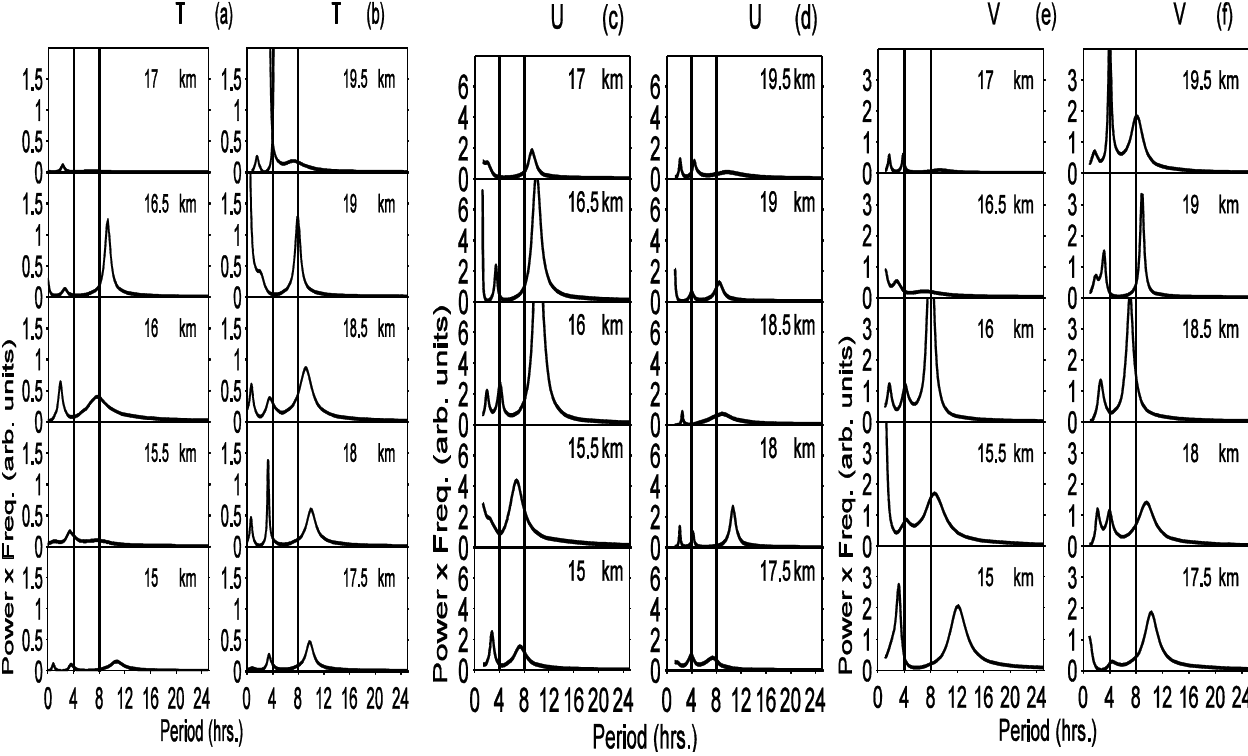
Fig. 8. From the spectrum of U , V , and T , we can infer dominant wave periods on 30 November 2005 at different height regions (from 15 Figure 8. From the spectrum of U, V, and T, we can infer dominant wave periods on 30 November 05 at to 19.5km, at an interval of 0.5km, mentioned in each plot) covering regions of WS1, tropopause, and WS2. Panels from left to right are different height regions (from 15 to 19.5 km, at an interval of 0.5 km, mentioned in each plot) covering shown for T (panels a , b ), U (panels c , d ), and V (panels e , f ). Vertical lines are drawn are drawn on x-axis at 4h and 8h, regions of WS1, tropopause, and WS2. Panels from left to right are shown for T (Panels a, b), U (Panels c, d), and V(Panels e, f). Vertical lines are drawn are drawn on x-axis at 4 hrs and 8 hrs, respectively.